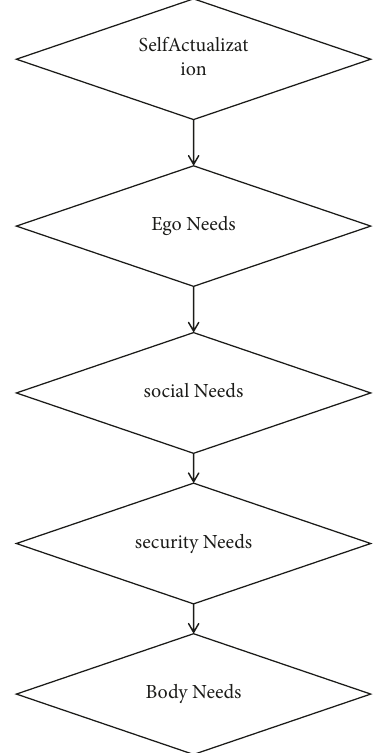
Figure 2: Hierarchy of needs theory